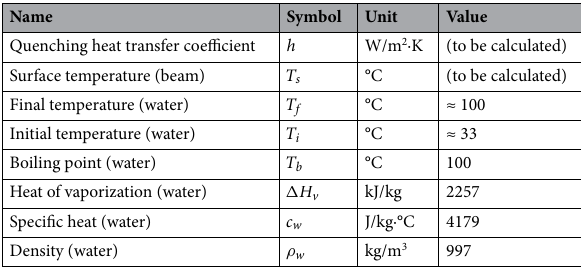
Table 4. Thermo-physical properties for calculating transferred